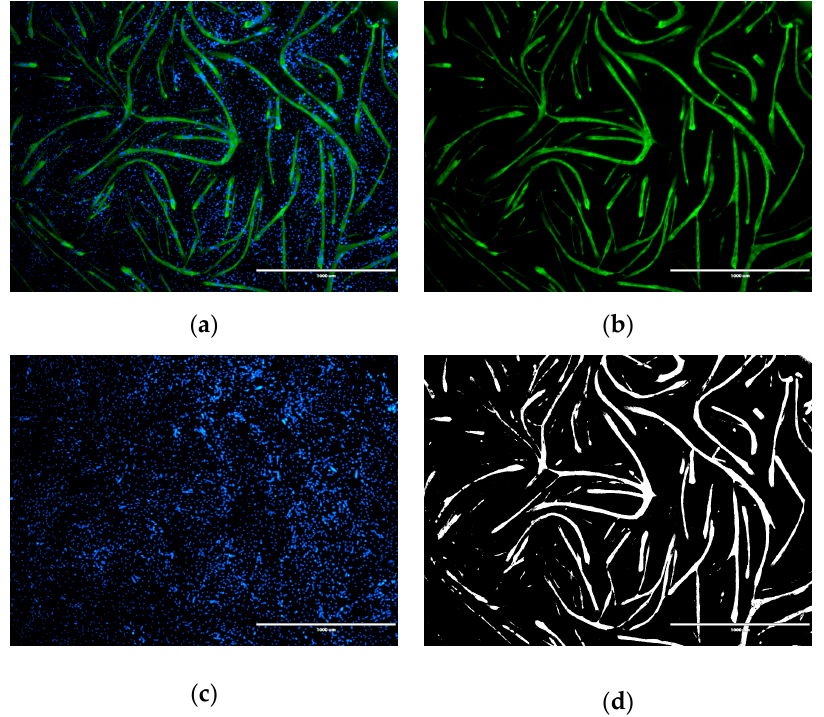
Figure 9. Immunofluorescence analysis of skeletal muscle cells differentiated for 5 days. Microscopic images: overlay (a) of the myosin staining (b) and the nuclei staining (c). To quantify the influence of vancomycin on myotube formation the binary image (d) was used.